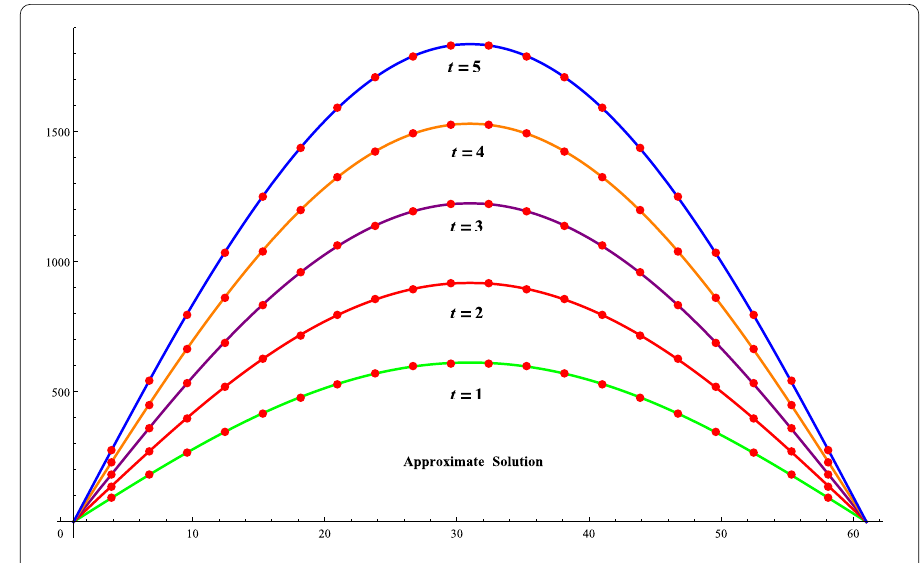
Figure 5 Approximate solution for Problem 2 at different time levels when (cid:2) t = 0.001, N = 60, α = 1.25